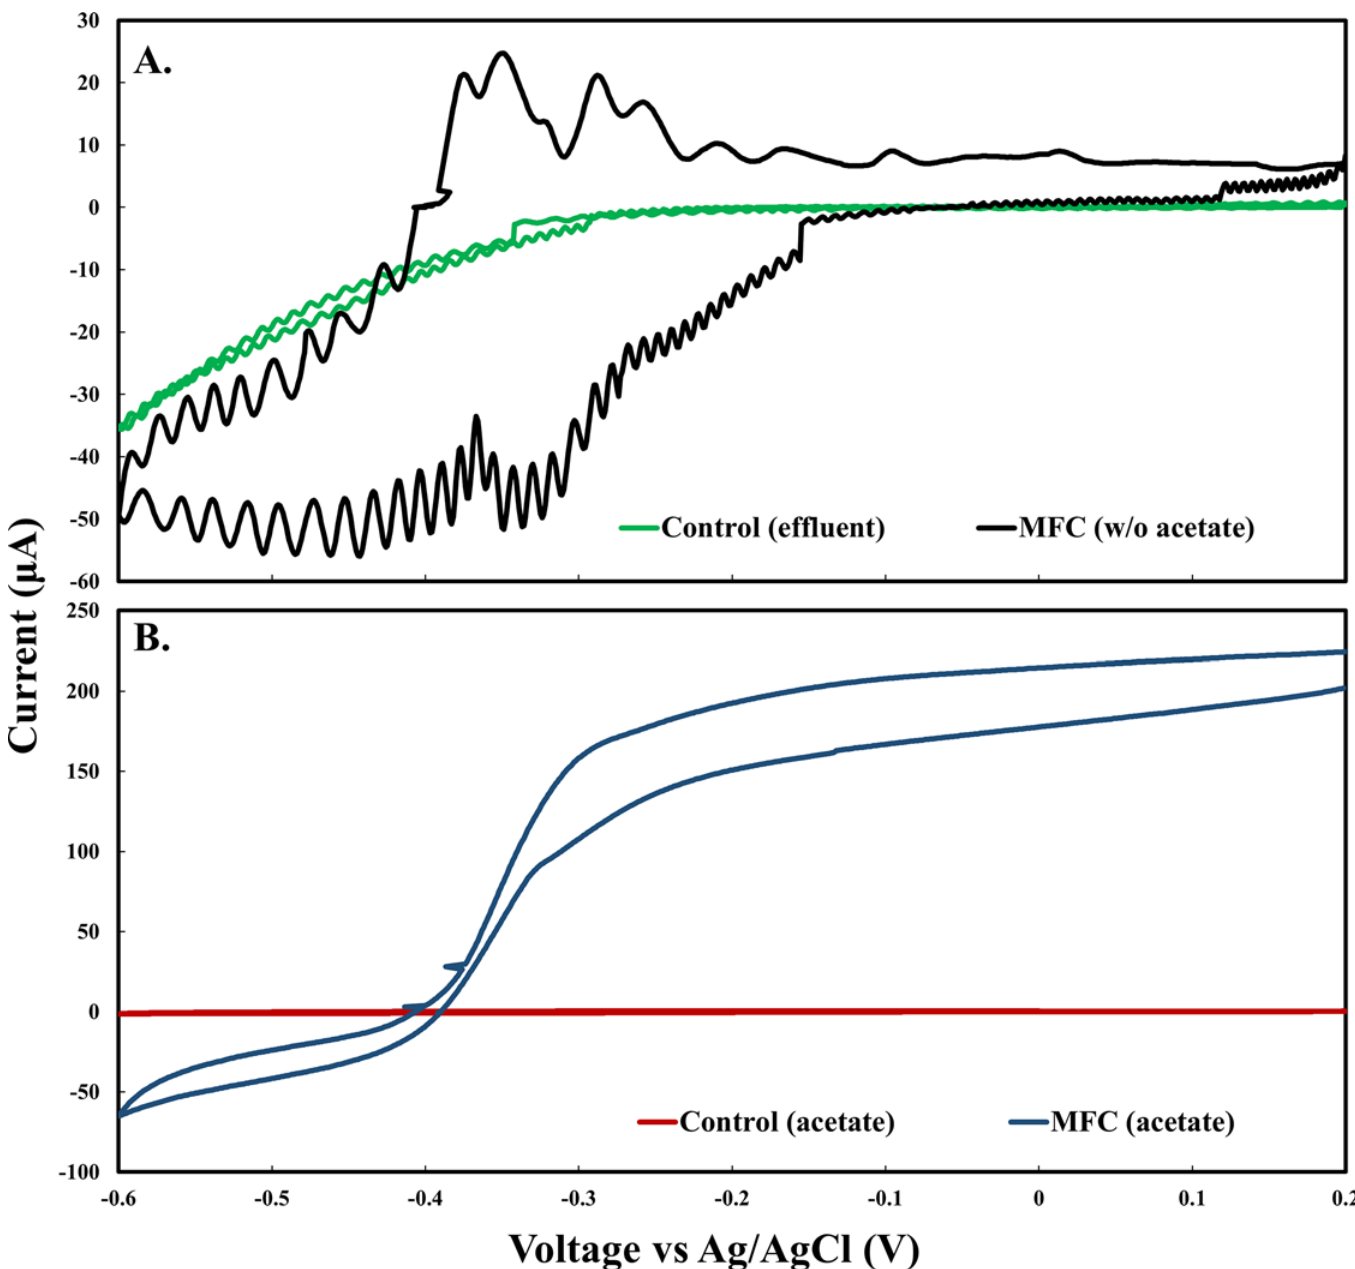
Fig 5. Cyclic voltammograms of mixed species biofilm. The voltammograms were recorded (A) in the absence of electron donor and (B) in the presence of electron donor. Scan rate was 1 mV S -1